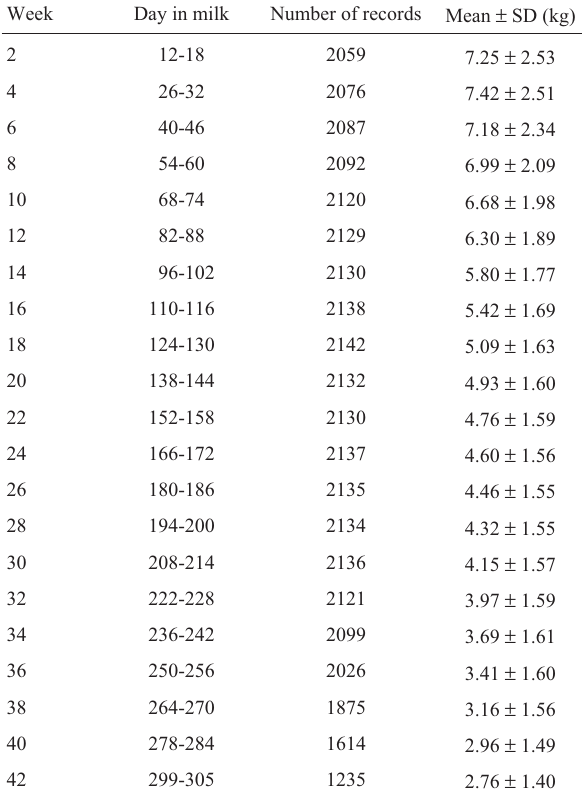
Table 1 - Days in milk, number of records, overall means and standard de- viations of test-day milk yields (TDMY) for the univariate